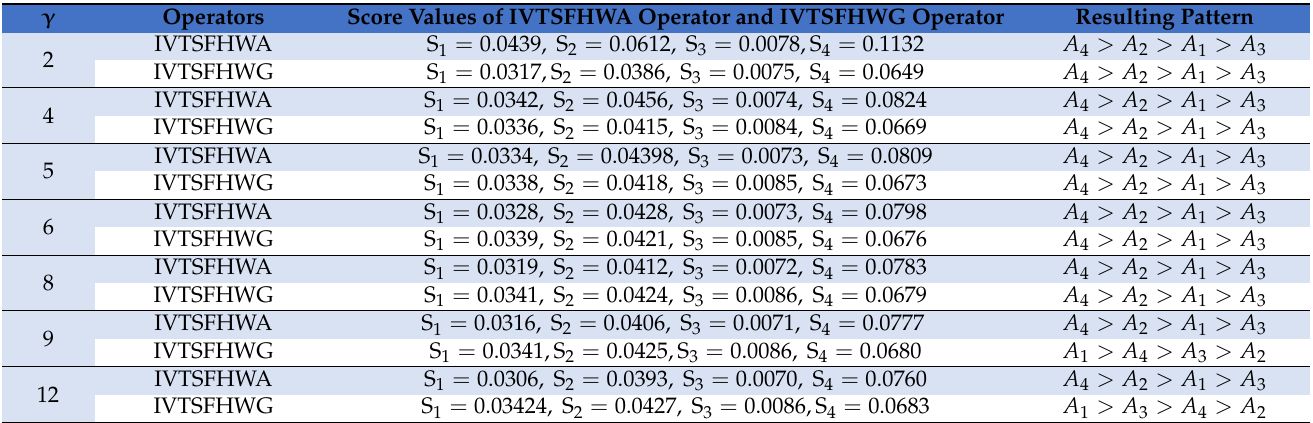
Table 4. Impact of γ on the ranking results.